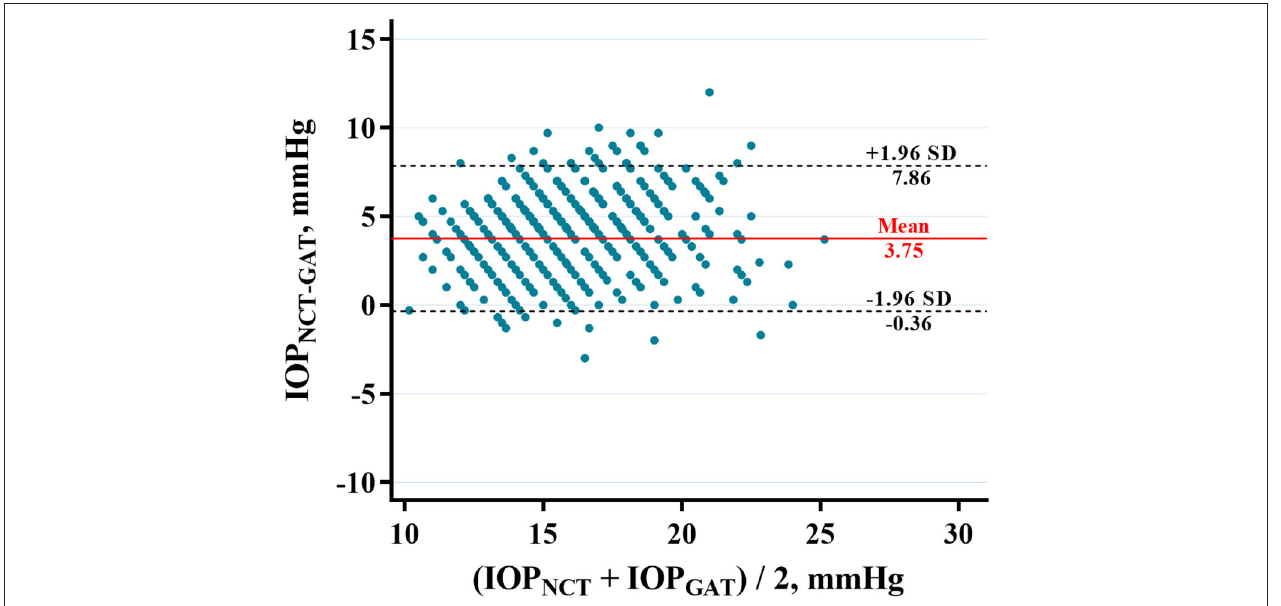
FIGURE 2 | Bland-Altman plot showing the agreement between IOP NCT and IOP GAT in highly myopic eyes. X axis, mean of IOP NCT and IOP GAT values. Y axis, the difference between IOP NCT and IOP GAT values. The two black dashed lines indicate mean difference ± 1.96 standard deviation between IOP NCT and IOP GAT ( − 0.36–7.86 mmHg). The red line indicates the mean difference in IOP (3.75 mmHg). IOP NCT , intraocular pressure measured with non-contact tonometer; IOP GAT , intraocular pressure measured with Goldmann applanation